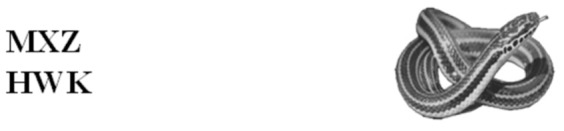
Example display of Experiment 4, depicting a high perceptual load trial with a snake distractor.Note that stimuli are not drawn to scale.